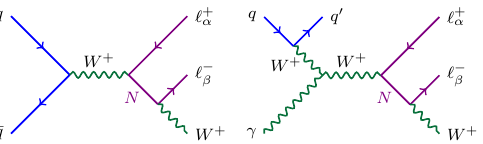
Figure 10. Feynman diagrams for production of heavy neutrino N at future hadron colliders (cf. the processes in Equation (7)). Figure from Ref.